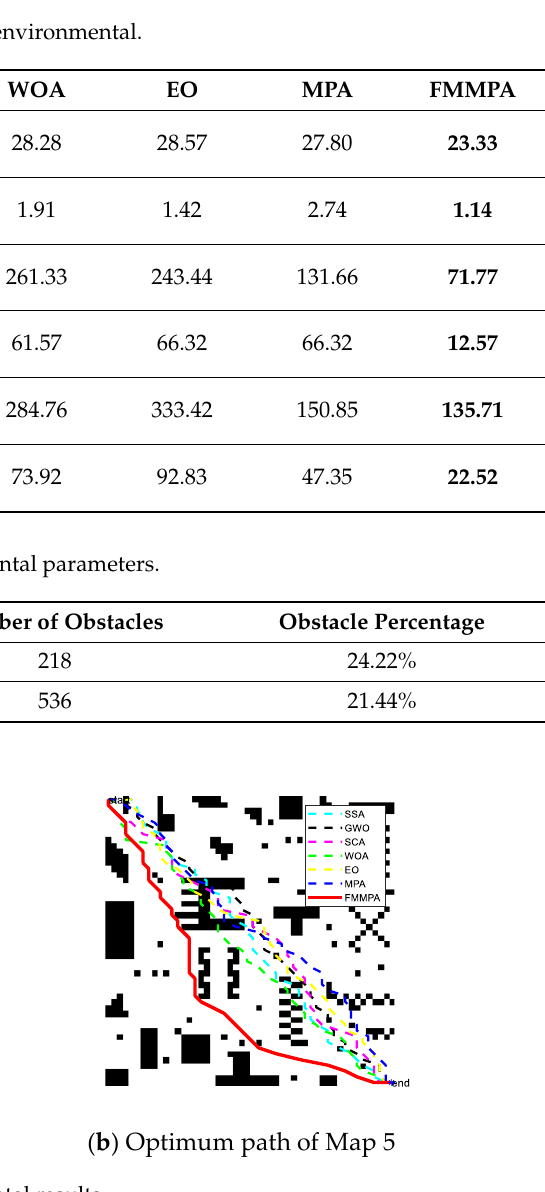
Figure 10. Complex environment experimental